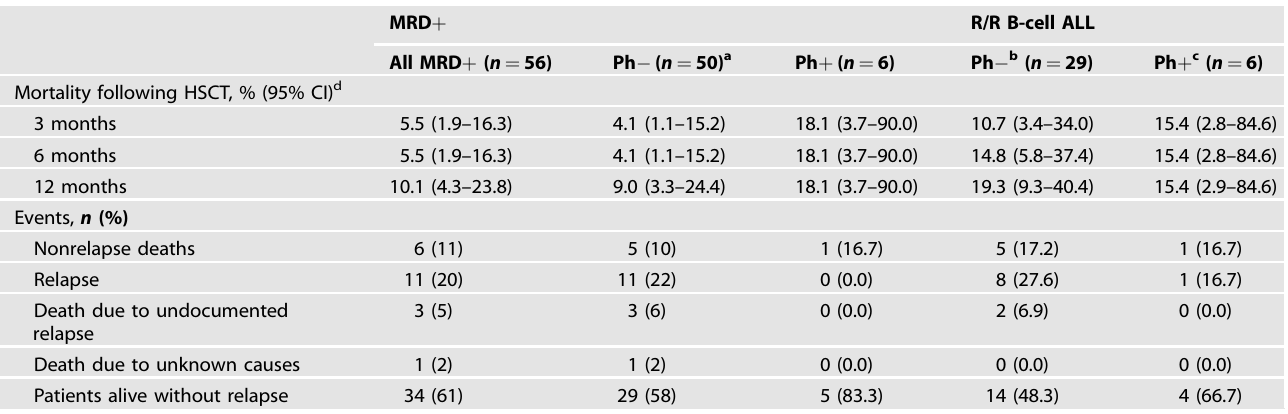
Table 2. Mortality after allogeneic HSCT by B-cell ALL